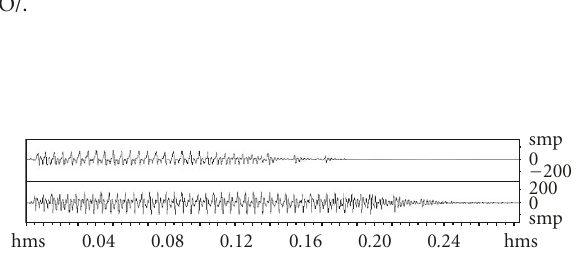
Figure 12: Lombard nonaudible murmur recorded at 80dBA.